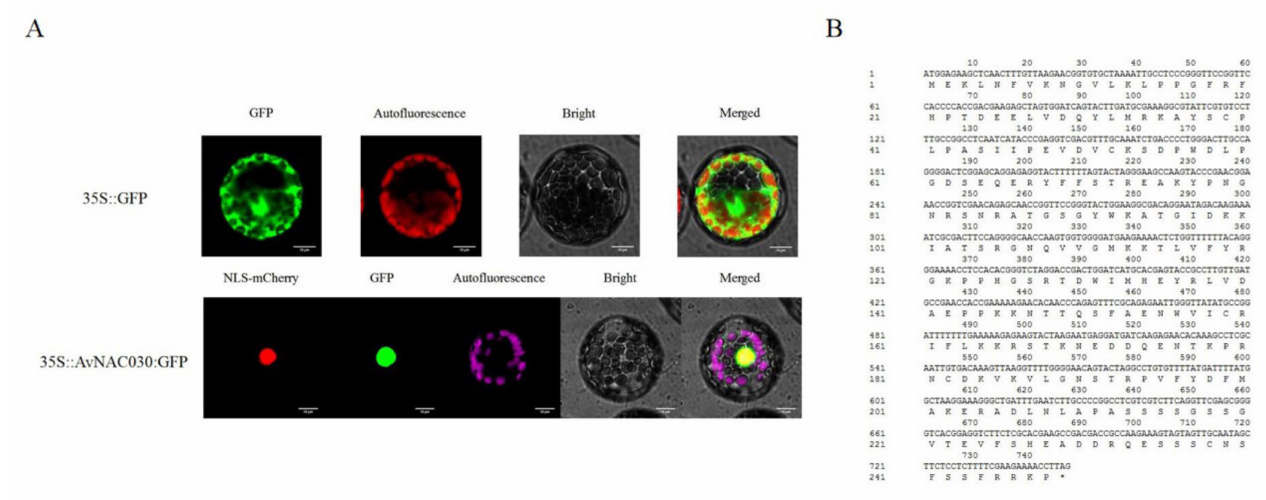
Figure 5. The interaction network analysis for AvNAC030 , AvNAC031 , AvNAC037 , AvNAC060 , and AvNAC098 . Note: AvNAC genes are shown in brackets.